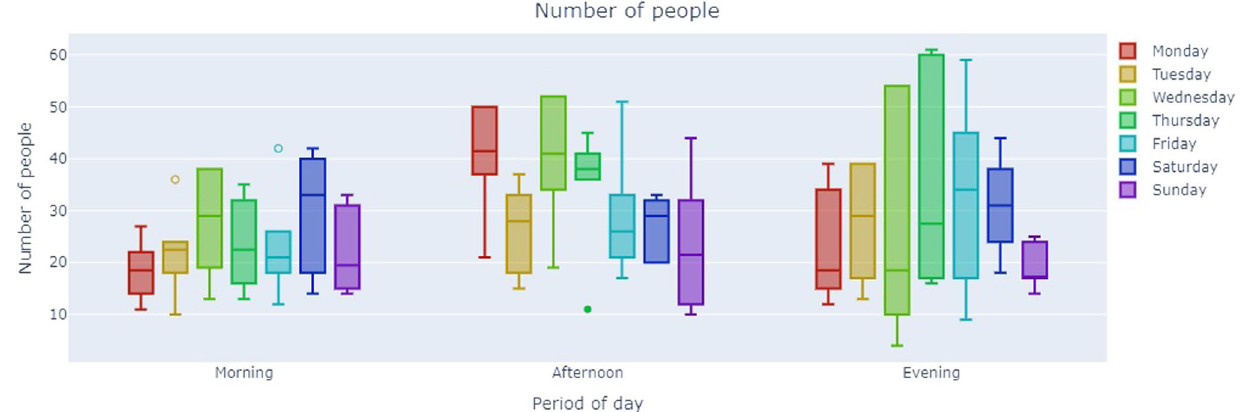
Fig. 7 Number of people